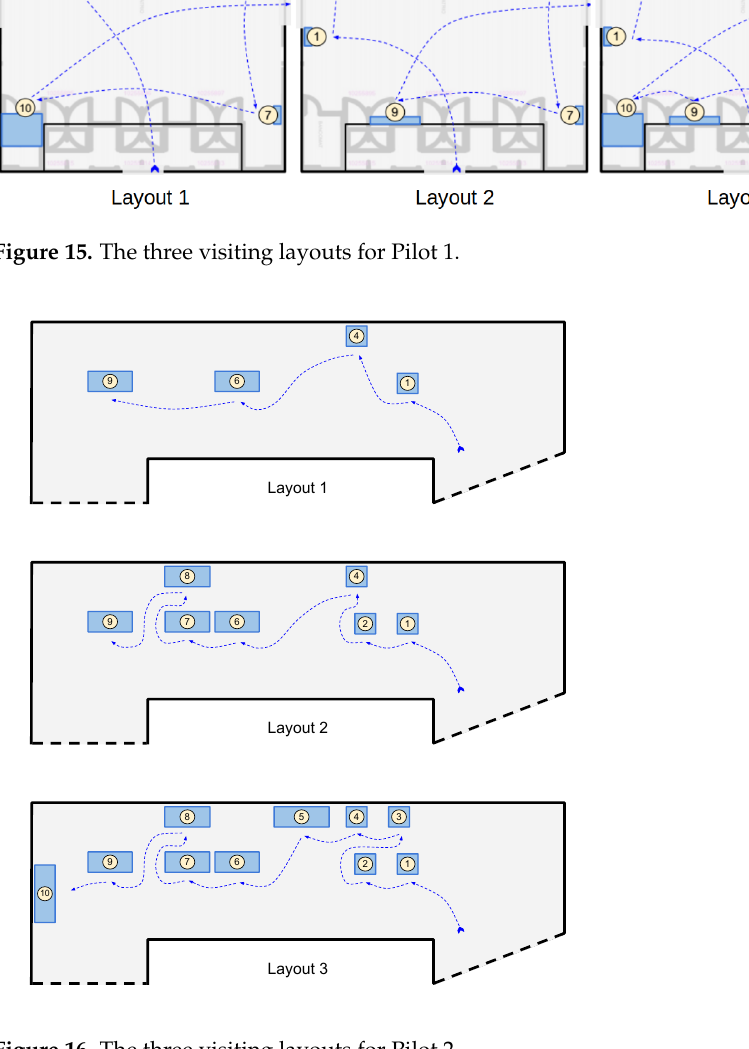
Figure 16. The three visiting layouts for Pilot